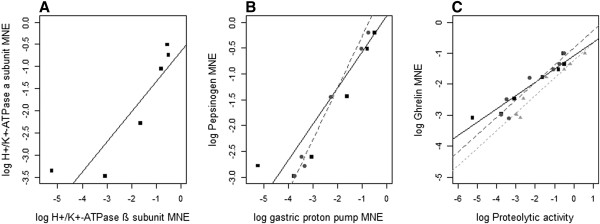
Linear regressions estimated from correlation analyses between stomach specific gene markers during Atlantic halibut ontogeny. Linear regression models were fitted to log-transformed mean expression values (MNE) of A) gastric H+/K+-ATPase α subunit and β subunit; B)pepsinogen A2 and H+/K+-ATPase β subunit (black squares and solid line) as well as H+/K+-ATPase α subunit (grey dots and dashed line); C)ghrelin and H+/K+-ATPase β subunit (black squares and solid line), H+/K+-ATPase α subunit (grey dots and dashed line) as well as pepsinogen A2 (light grey triangles and dotted line). All correlations are significant (p < 0.05). The log-transformed mean of MNE per stage (5 to10) was taken from six individuals.